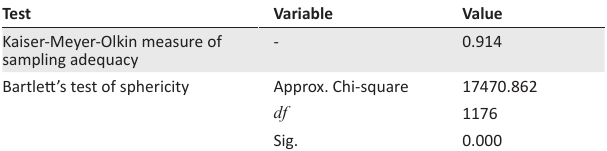
TABLE 2: Kaiser-Meyer-Olkin and Bartlett’s test.